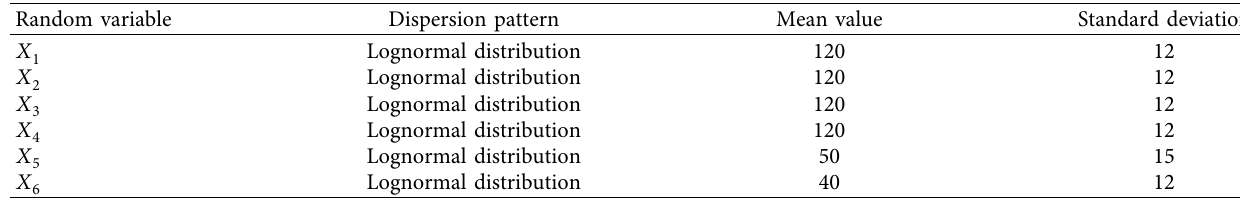
Table 3: Random variable distribution of example 3.